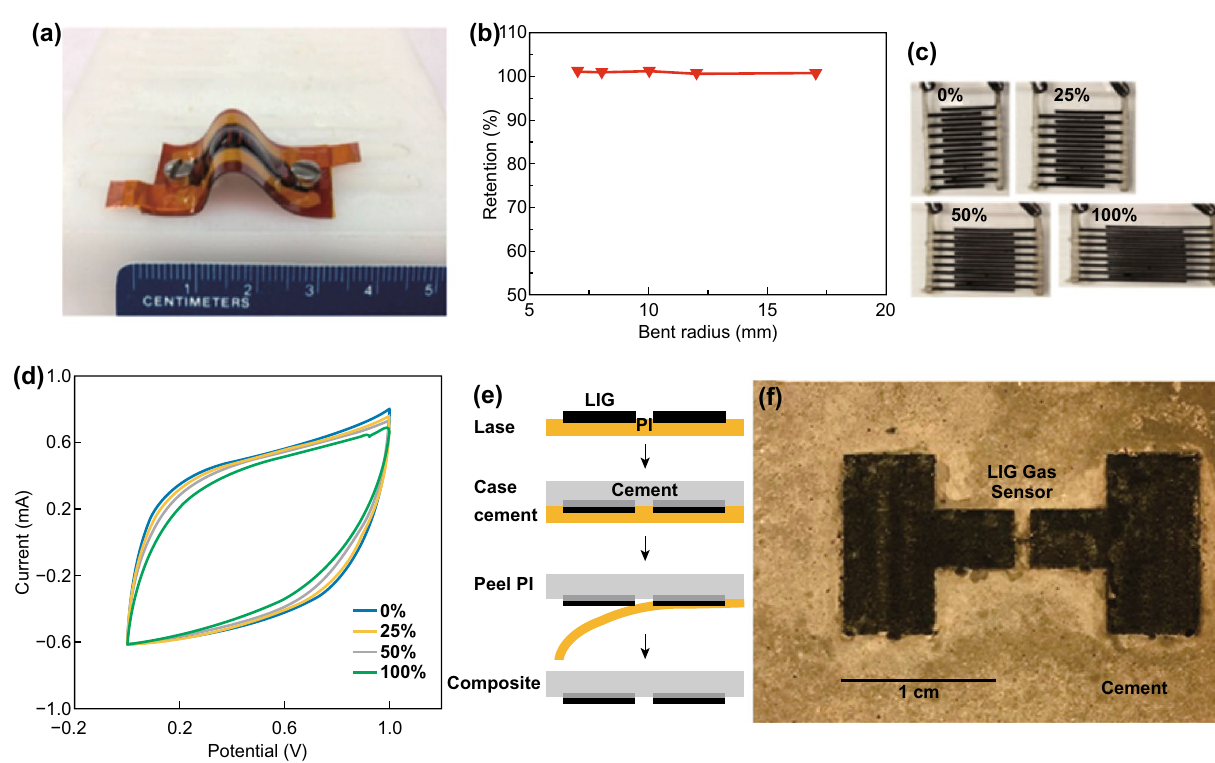
Fig. 2 Mechanic LIG and its composites. a Digital photograph of a bent boron-doped LIG at a bending radius of 10 mm. b Capacitance reten- tion of boron-doped LIG capacitance at different bending radii. a , b Adapted with the permission from Ref. [27], Copyright 2018 Elsevier Ltd. Images c and stretchability test d of a S-MSC at 0, 25, 50, and 100% stain. c , d Adapted with the permission from Ref. [46], Copyright 2019 WILEY-VCH Verlag GmbH & Co. KGaA, Weinheim. e Schematic showing the process of embedding a LIG-based sensor into cement. f Opti- cal image of the LIG sensor-embedded in cement. e , f Adapted with the permission from Ref. [47], Copyright 2019 American Chemical